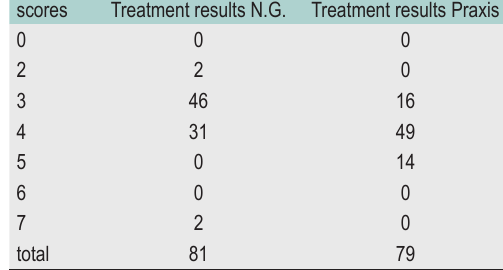
TABLE 5. Presentation of treatment results in average in respondents with bilateral gonarthrosis in clinics D.Z. “Novi Grad” and "Praxis". scores Treatment results N.G.